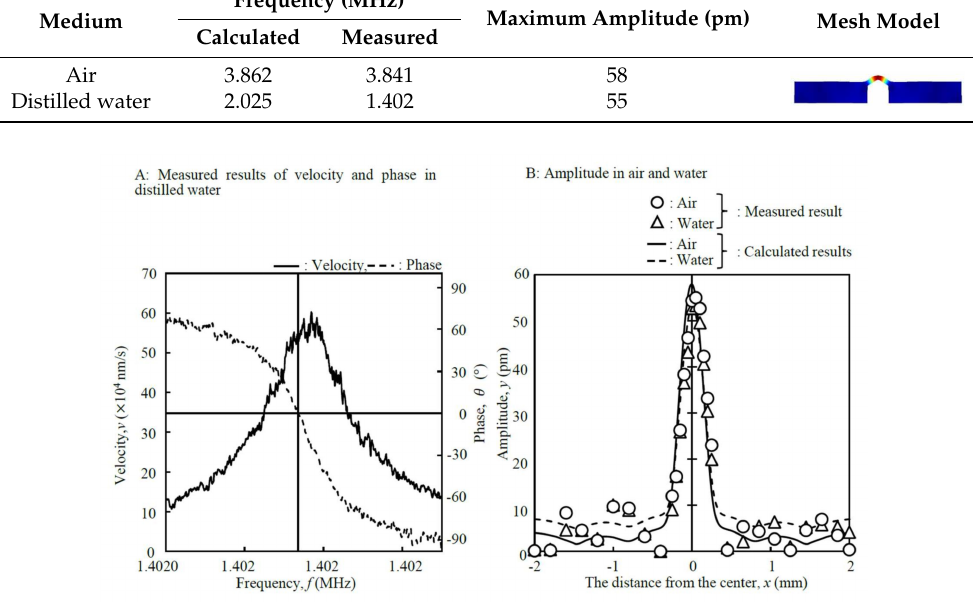
Figure 6. Resonance characteristics of the fabricated disk-shaped resonator at room temperature (25 ◦ C).